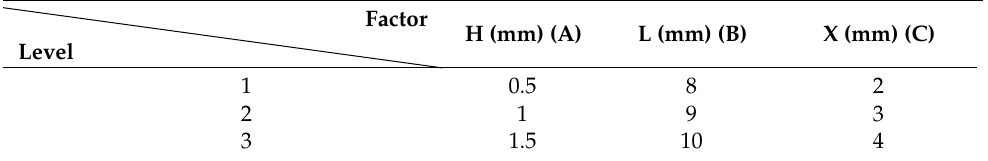
Table 1. Structural parameters of fuze airflow-induced acoustic generator.